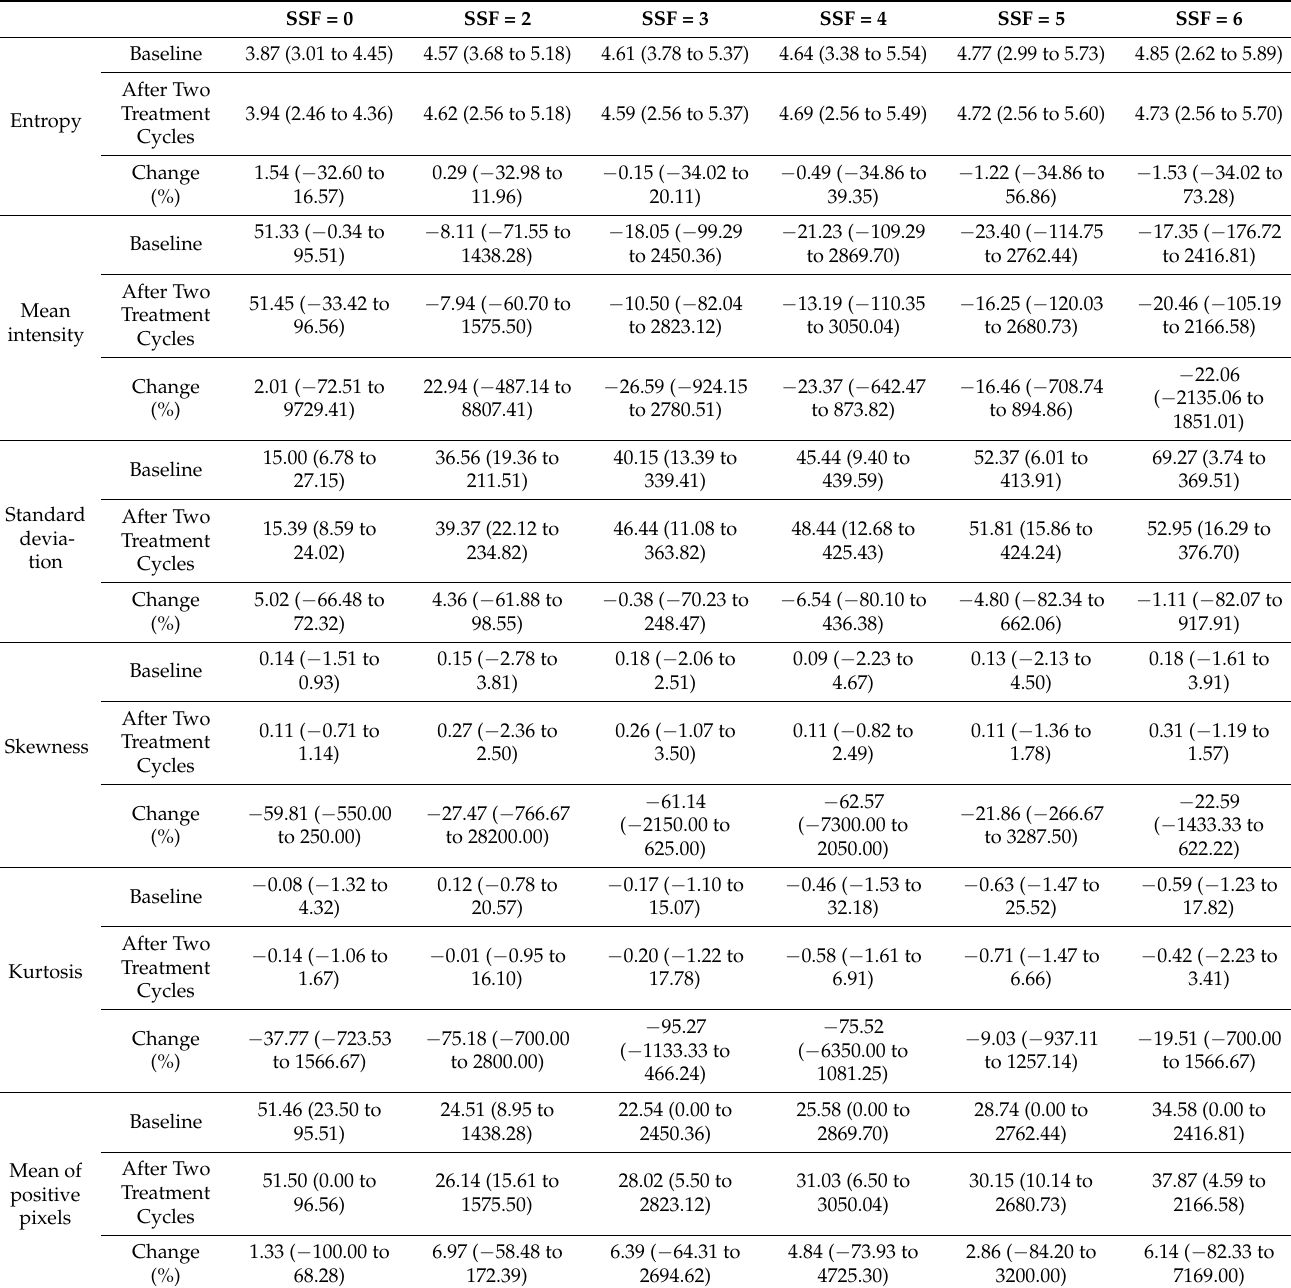
Table 3. Median value and percentage change for texture parameters for spatial scaling factor (SSF) at baseline and after two treatment